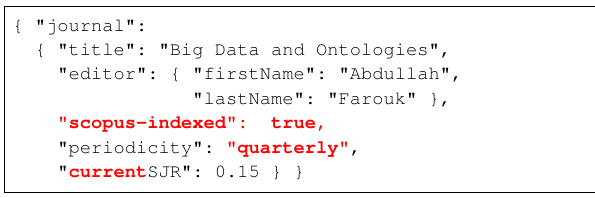
Fig. 10 JSON Fig. 11 The generated JSON Schema of